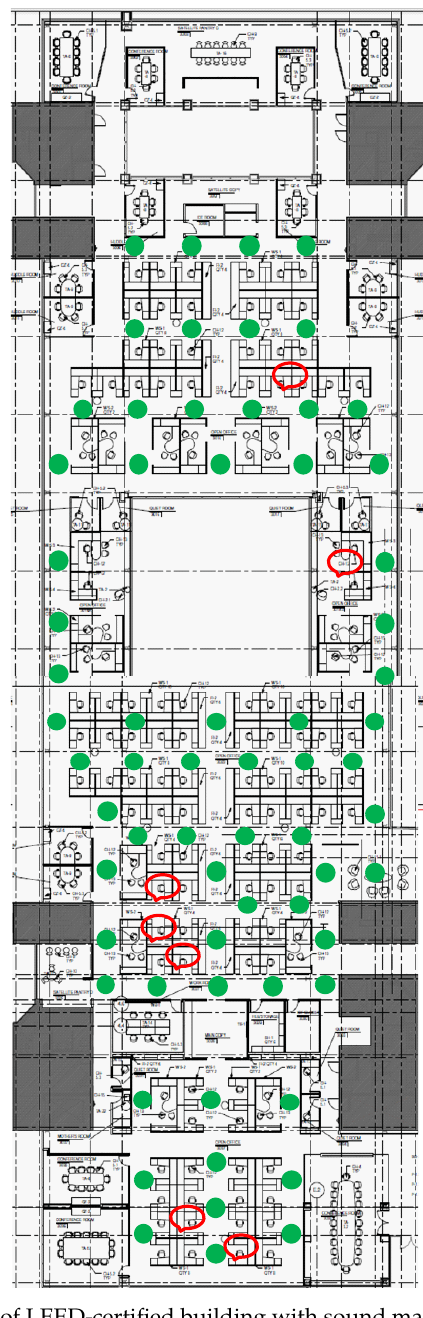
Figure 2. Background noise survey north wing of LEED-certified building with sound masking on ( left ) and off ( right ). The green dots denote values that met the design criteria during occupied hours whereas the red dots denote values exceeding 48 dB A . Design criteria were exceeded in some instances due to nearby conversation, denoted by the red, unfilled oval